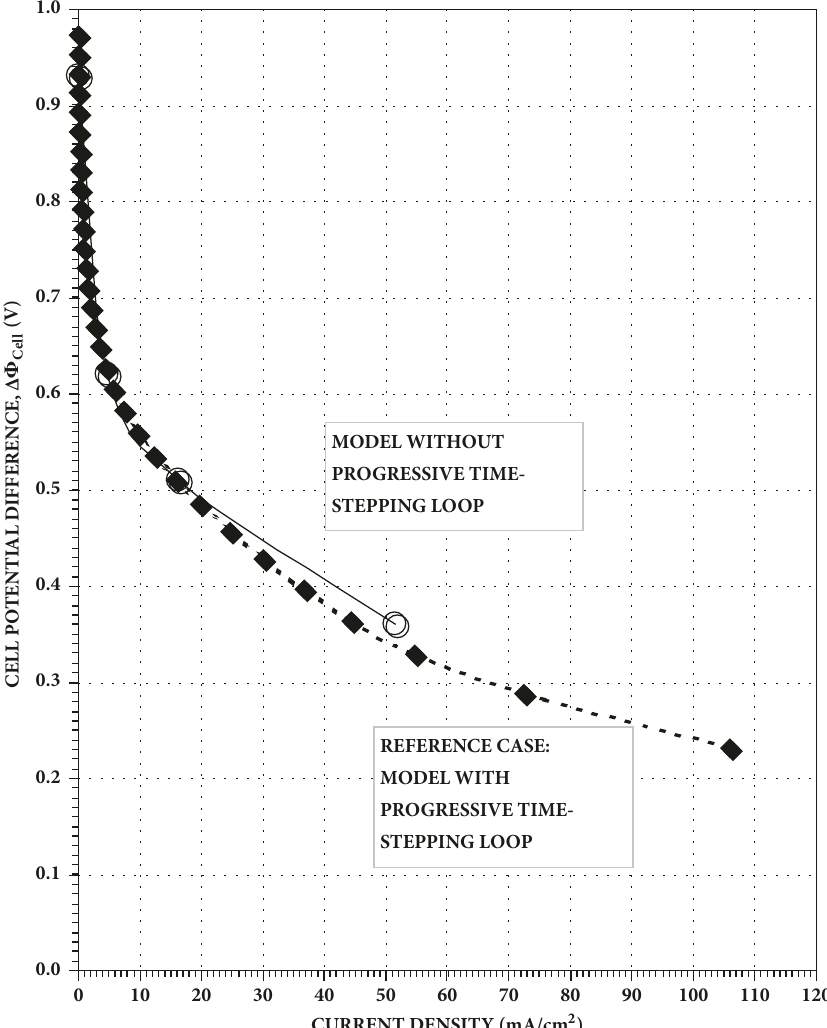
Figure 2: The effect of progressive and nonprogressive time-stepping loops on the polarization curve for a direct propane fuel cell model (DPFC) at 150 ∘ C and 1 atm. The above two cases were represented by the following symbols: (i) open circles: model without a progressive time-stepping loop, and (ii) solid diamonds: model with a progressive time-stepping